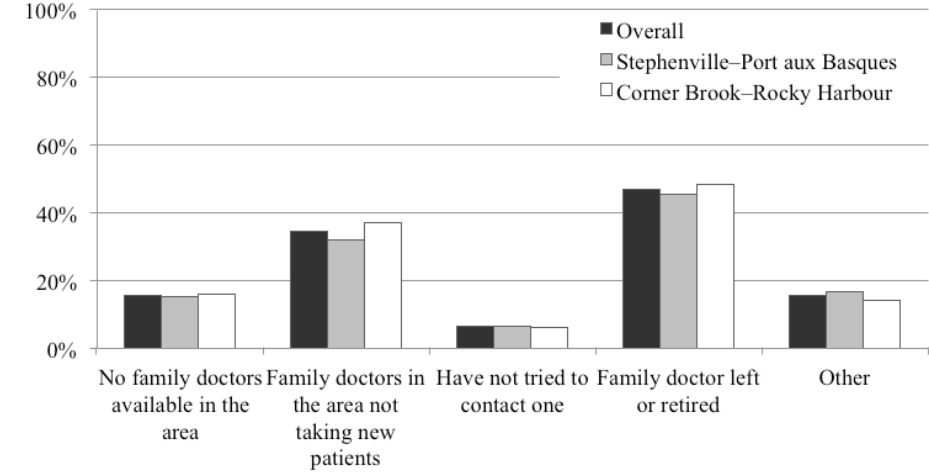
Main Health Contacts